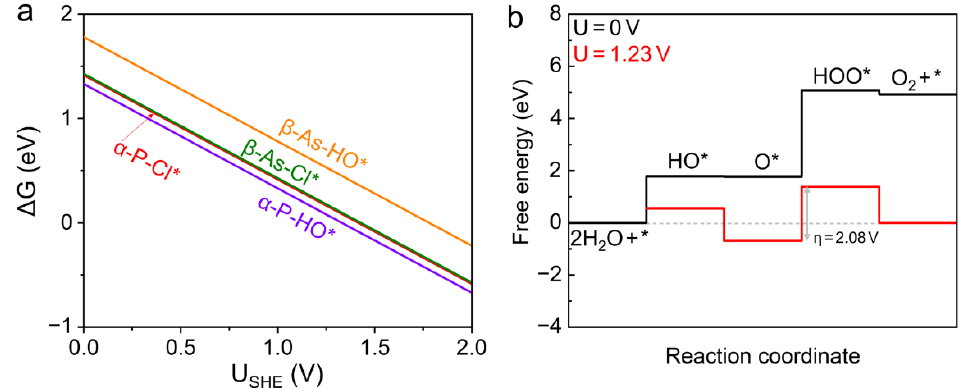
Figure 5. ( a ) The adsorption free energy for Cl* and HO* on α -phosphorene and β -arsenene monolayers as a function of the theoretical standard hydrogen electrode potential (U SHE ) at pH = 0; ( b ) Gibbs free energy diagram for OER on β -arsenene monolayer.